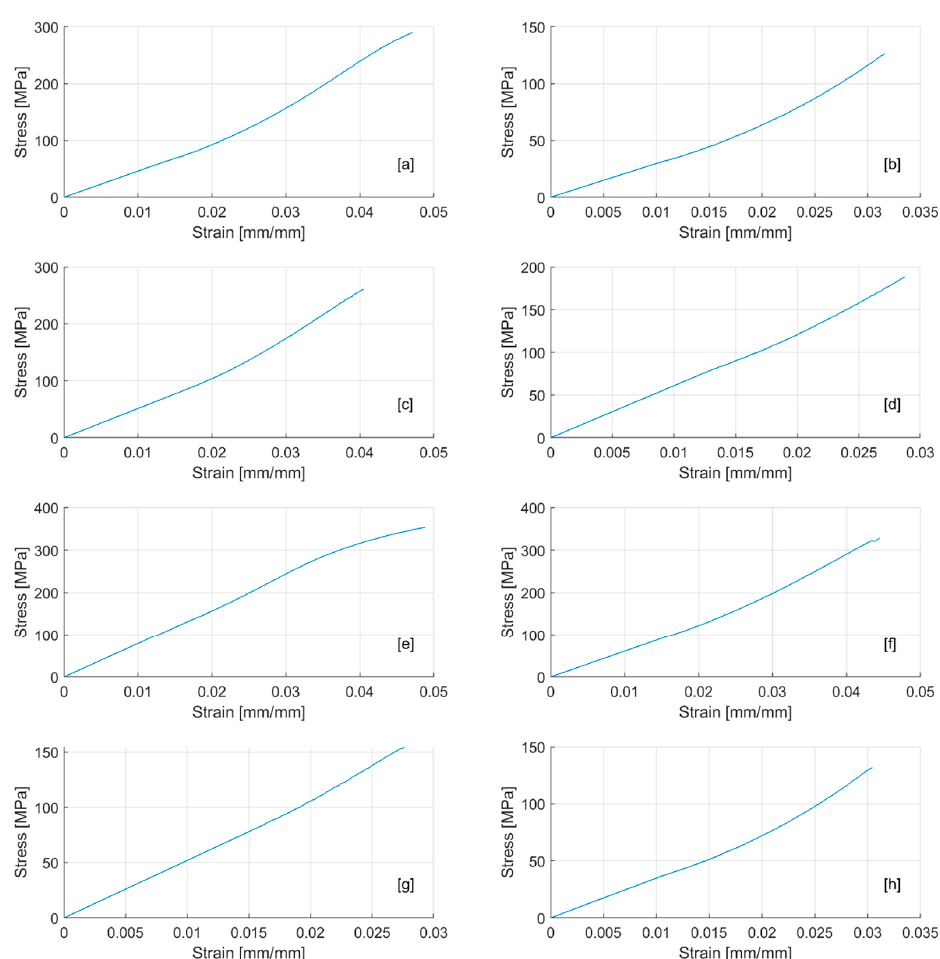
Figure 4. Stress-strain curves of 2 mm Al7075 FSW specimens: ( a ) Pin3 1000 rpm 80 mm/min; ( b ) Pin3 1000 rpm 300 mm/min; ( c ) Pin3 2000 rpm 400 mm/min; ( d ) Pin3 2000 rpm 800 mm/min; ( e ) Pin4 1000 rpm 80 mm/min; ( f ) Pin4 1000 rpm 300 mm/min; ( g ) Pin4 2000 rpm 400 mm/min; ( h ) Pin4 2000 rpm 800 mm/min.